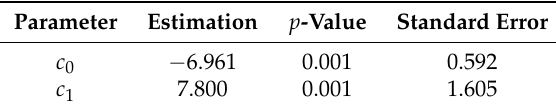
Table 3. Estimation results of Equation (8) for α = 5%.